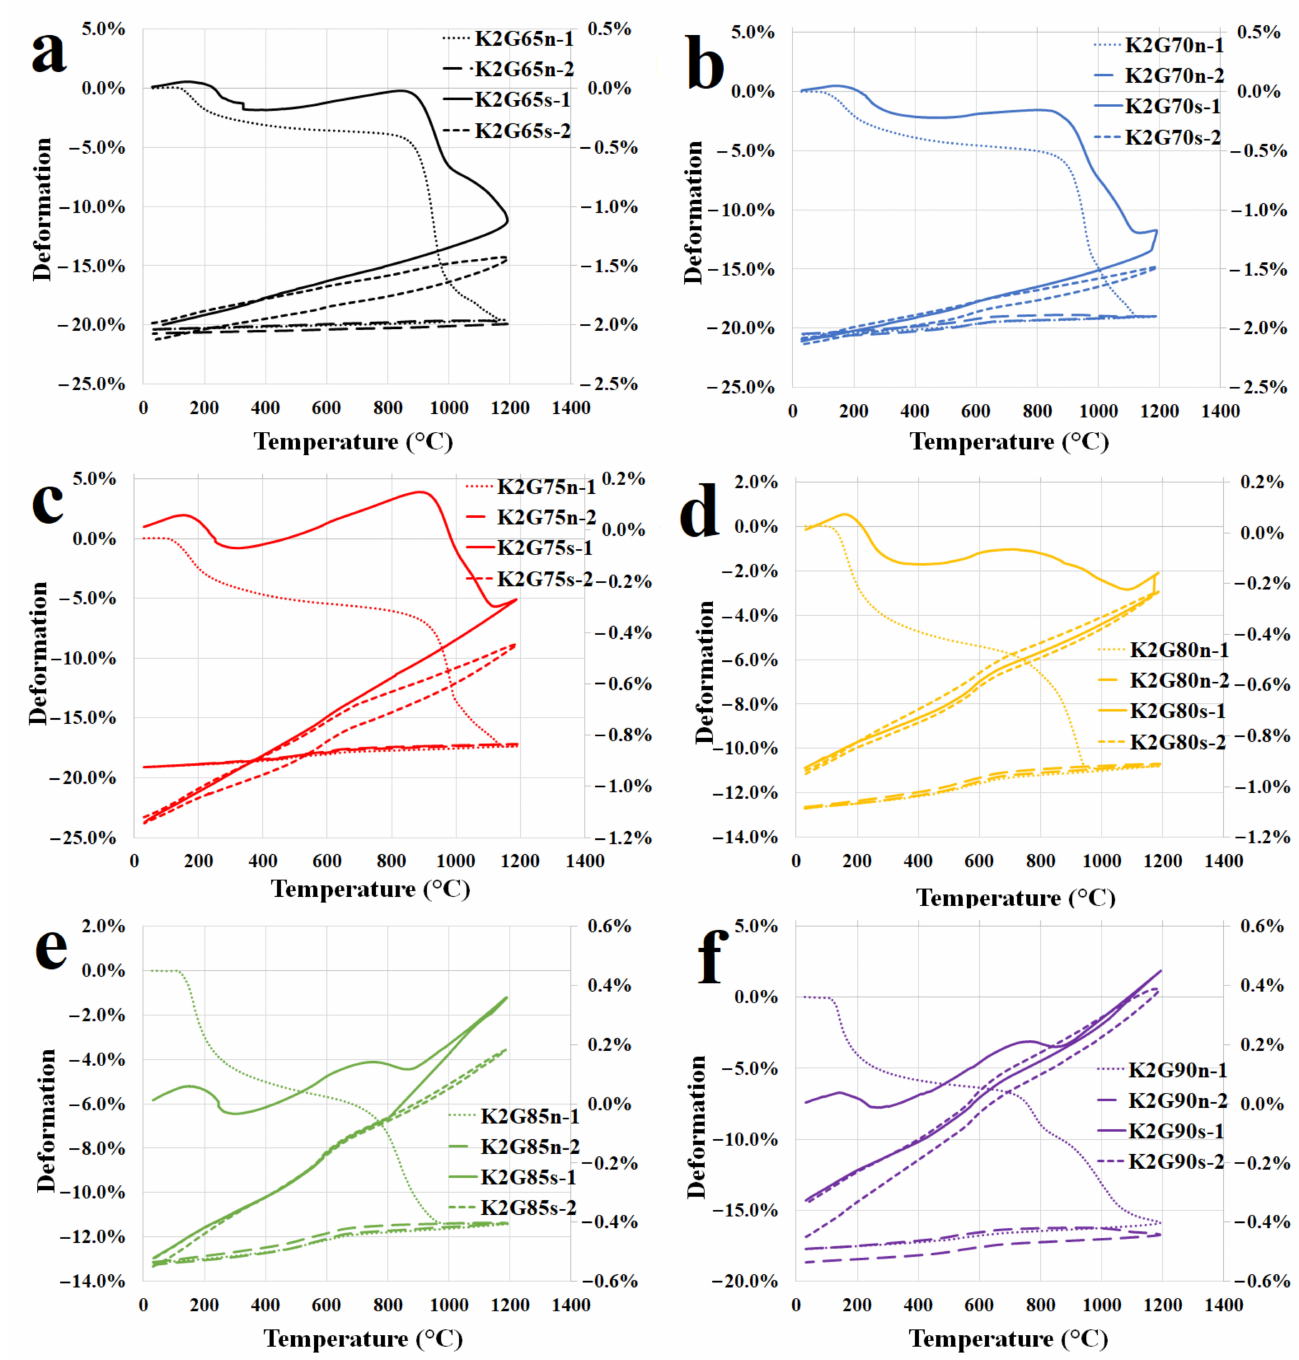
Figure 4. The dilatometric curves of the first and second runs of geopolymer binders (y-axis on the left) and composites (y-axis on the right) with various molar ratios of K/Al (( a )—GB-0.55 and GS-0.55, ( b )—GB-0.70 and GS-0.70, ( c )—GB-0.85 and GS-0.85, ( d )—GB-1.0 and GS-1.0, ( e )—GB-1.15 and GS-1.15, ( f )—GB-1.30 and GS-1.30) up to 1200 ◦ C (5 ◦